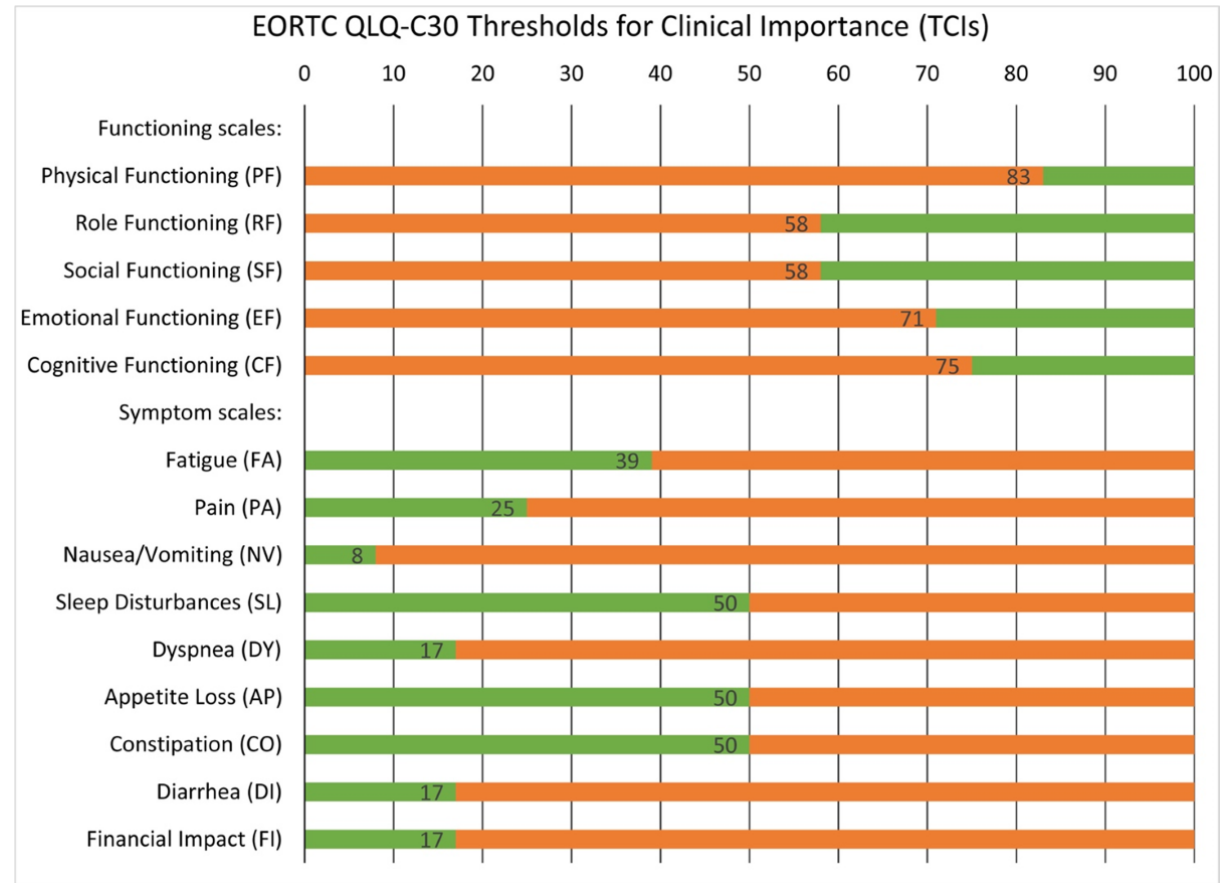
Figure 3. EORTC QLQ-C30 thresholds for clinical importance (TCIs). TCIs are shown inside the bars. Patient scores in the orange range of the bar (ie, below the TCI for functioning scales or above the TCI for symptom scales) indicate clinically important problems or symptoms. Reprinted from Giesinger et al (2020) [35]). EORTC: European Organisation for Research and Treatment of Cancer; QLQ-C30: Quality of Life Questionnaire–Core.